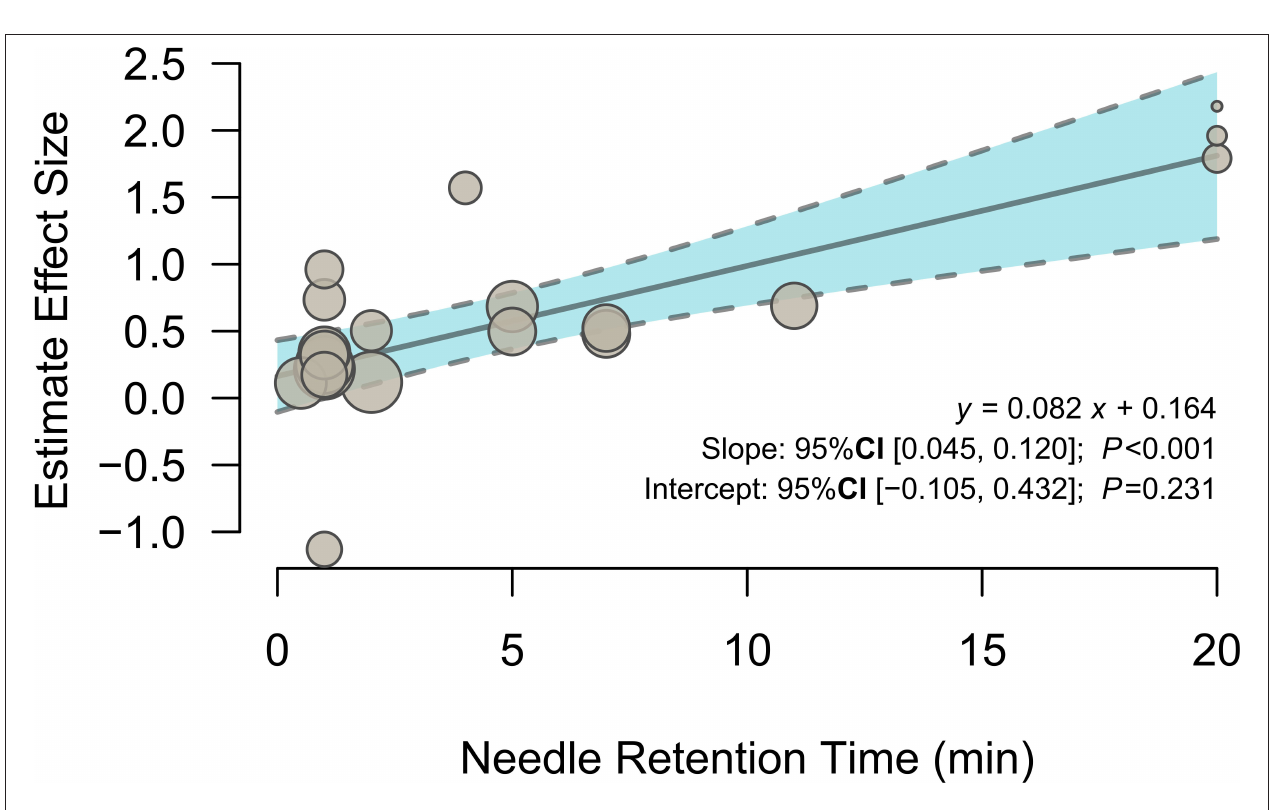
FIGURE 3 | Meta-regression of the relationship between needle retention time and the estimated effect size of the left olfactory cortex.